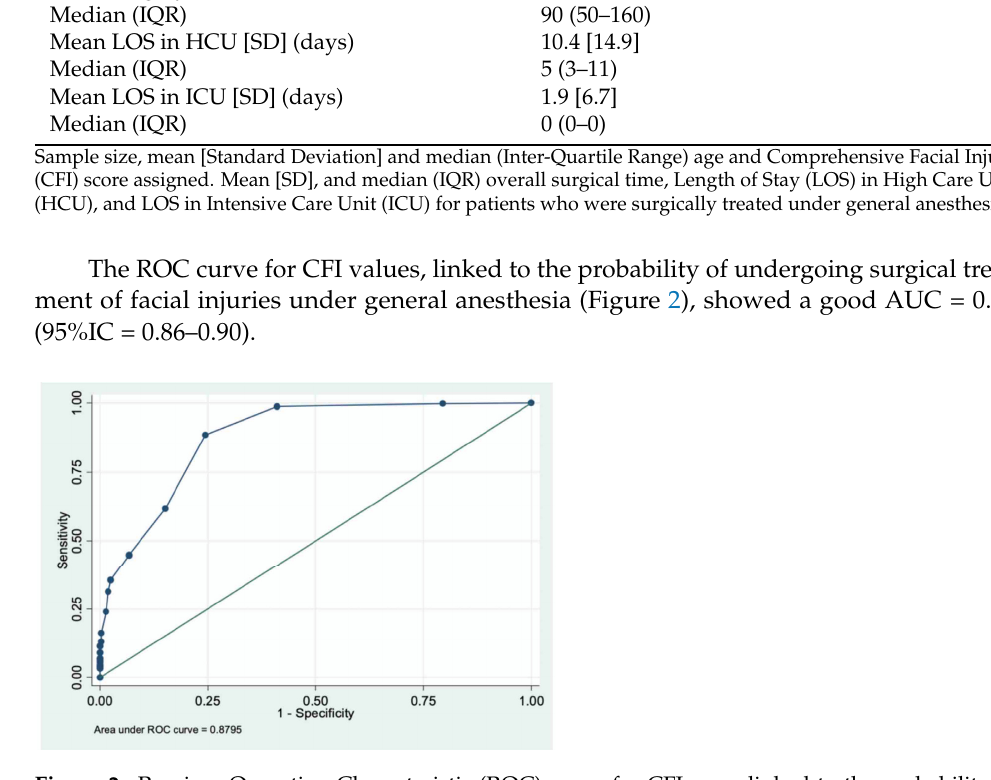
Table 1. Sample general characteristics and main outcomes.